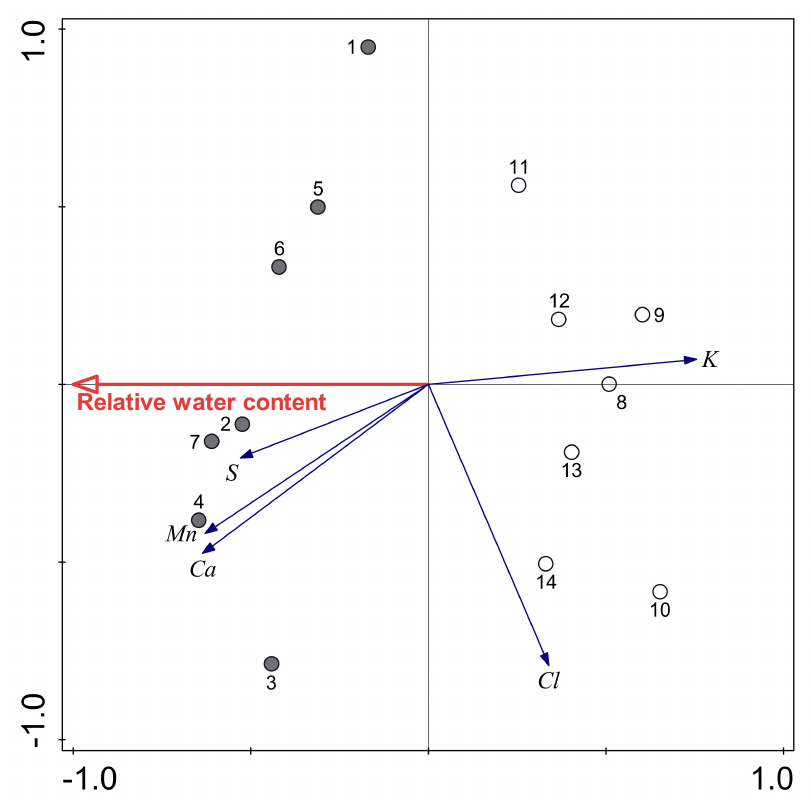
Figure 7. Redundancy analysis plot showing the strengths of associations between relative water content and element contents in the buckwheat leaves. Filled circles, control; open circles, water